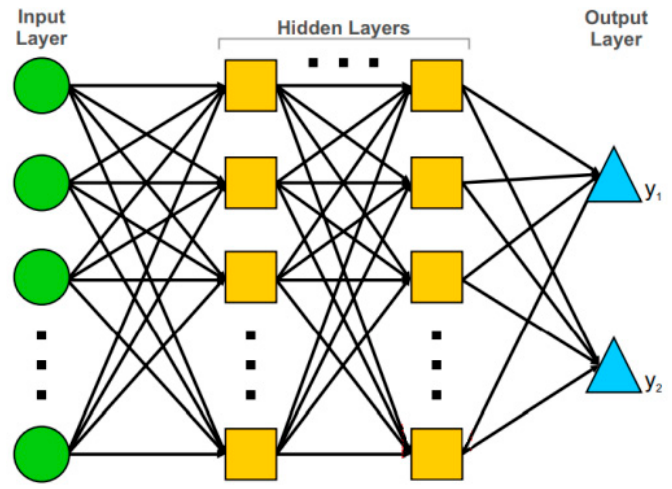
Figure 7. The architecture of a multilayer perceptron (MLP) [53].